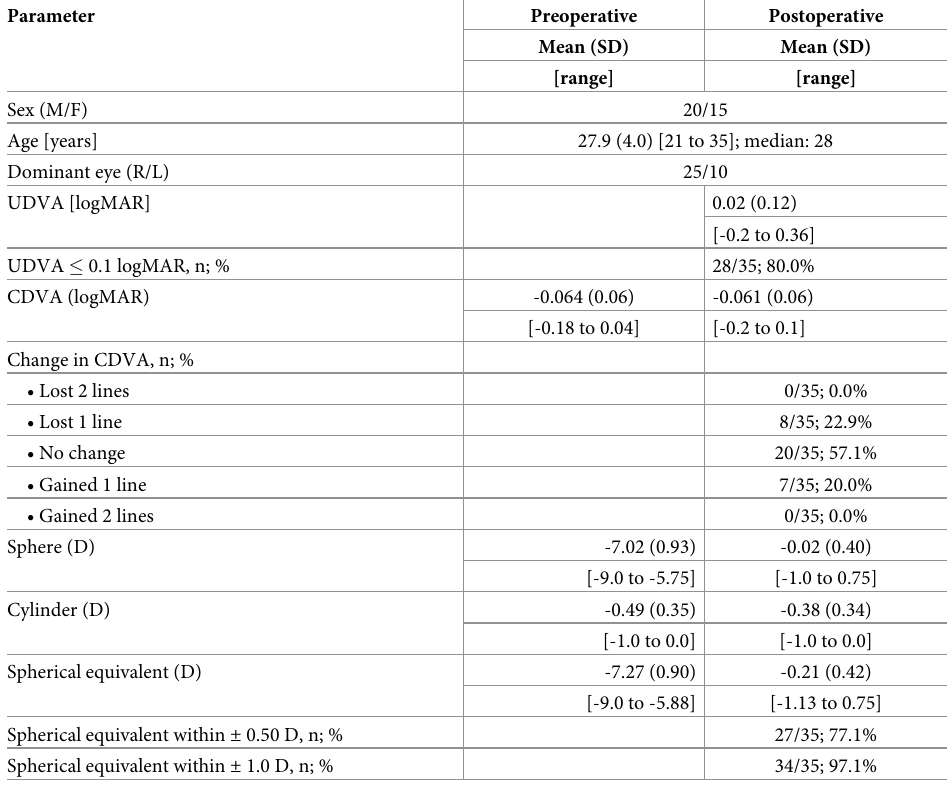
Table 1. Demographic